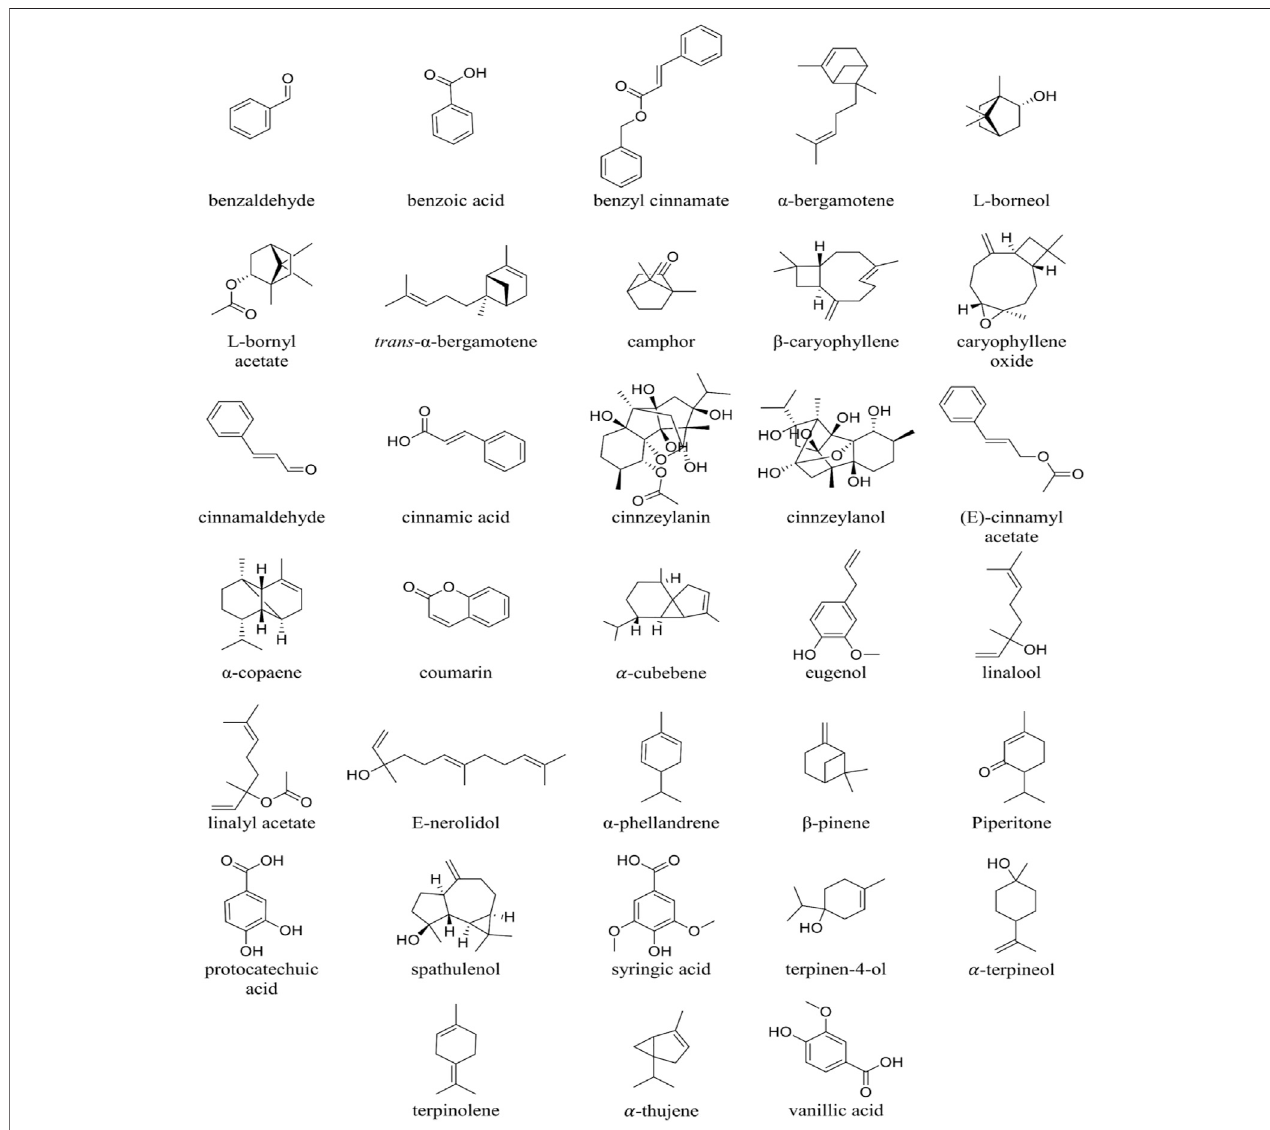
FIGURE 1 | Chemical structures of t he phyto-constituents of Cinnamomum species.